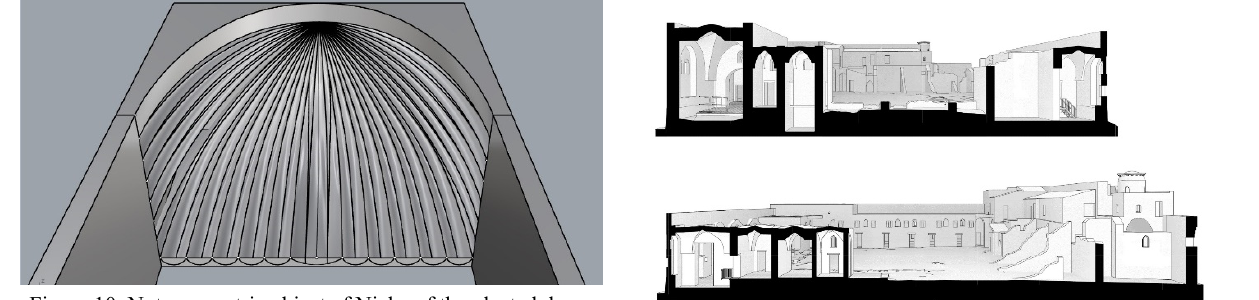
Figure 10. Not-parametric object of Niche of the pleated dome of the “ Aula Regia ”.